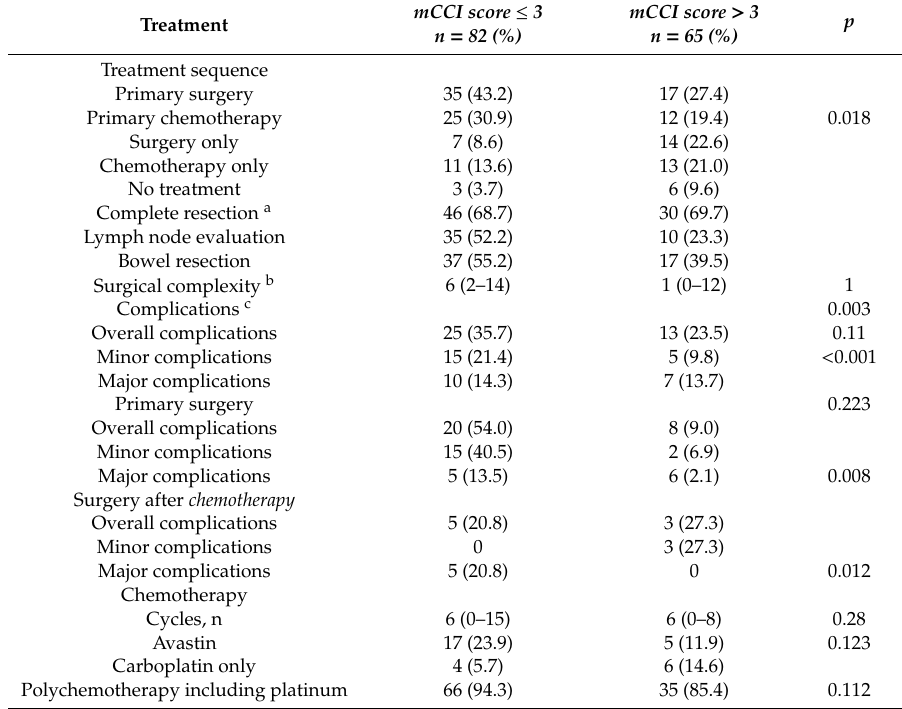
Table A3. Treatment stratified by mCCI